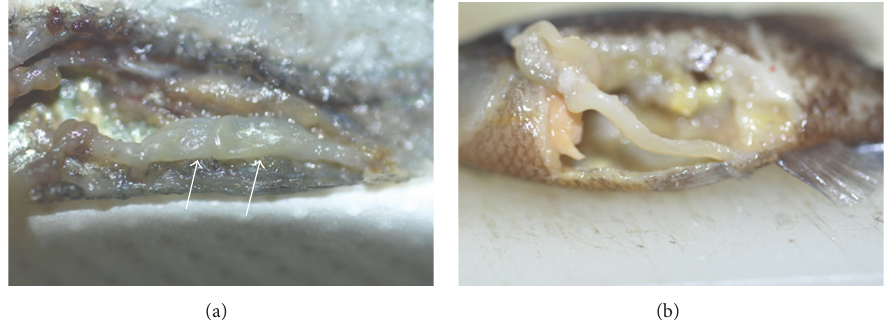
Figure 4: Dilated distal intestine (arrows) of an adult female with recurrent abdominal distension (a); normal distal intestine of a control fish